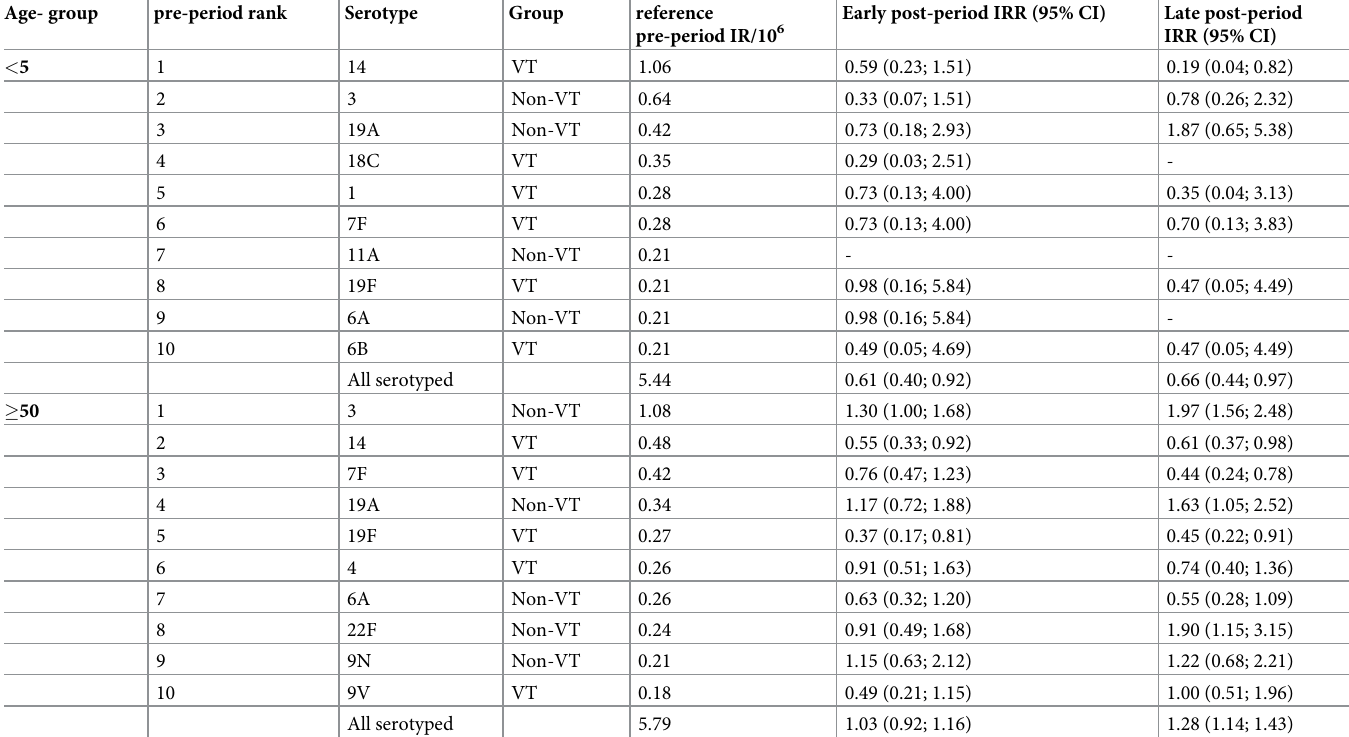
S2 Table. Serotype-specific analyses: monthly average incidence rate of the pre-period (pre-period IR as reference), pre-early post and pre-late post IR ratios with 95% confidence interval (CI) of the top 10 serotypes of the pre-period among < 5 and � 50 years old, Austria, January, 2009-February, 2017. Age-